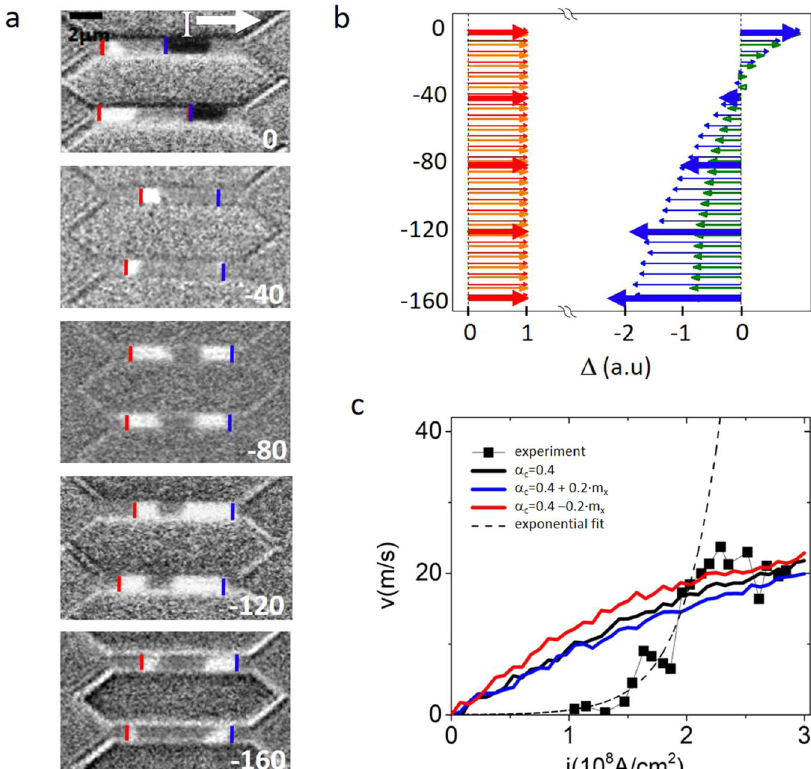
Fig. 2 Current induced DW motion. a . Differential Kerr images showing CIDM for different values of H ip , shown in white (values in mT) on each image. Dark and white contrast indicates that up/down and down/up DWs are displaced in the same direction. Red and blue lines mark the starting positions for the DWs with opposite up/down polarities. The current density is fi xed at 1·10 8 A/cm 2 . The pulse sequences used for each image are, from top to bottom: 10000 · 2 ns; 1000 · 1.5 ns; 100 · 1.5 ns; 200 · 1.2 ns; 300 · 1 ns b . Comparison of relative DW displacements extracted from the MOKE images (bold red and blue arrows) with numerical simulations. Since for every value of H ip in the experiment we had to use a different pulse sequence, it is impossible to extract accurately the DW velocity. Therefore, to evidence chiral effects, we compare the respective displacement of the two DWs by normalizing to the value of the positive displacement (in red). Orange and green arrows correspond to the scenario of α 1 = 0.4 and α 2 = 0. Red and blue arrows correspond to α 1 = 0.4 and α 2 = 0.2. In the absence of chiral damping, the displacements at large H ip become symmetric. The DWs move by the same amount in opposite directions. The reversal of the asymmetry observed experimentally, with the backward moving DW displacing a larger distance (blue arrows), is only reproduced in our model if we include the chiral damping. c . DW velocity as a function of current density (black symbols) for H ip = 0. The numerical model reproduces well the data in the range of high current density, above 2·10 8 A/cm 2 and 20 m/s, within the boundaries of the fl ow regime. The dotted line is an exponential fi t of the velocity in the intermediate range of current from 1·10 8 A/cm 2 to 2·10 8 A/cm 2 . It is a guide for the eye to visualize the separation of the fl ow regime from the thermally activated DW